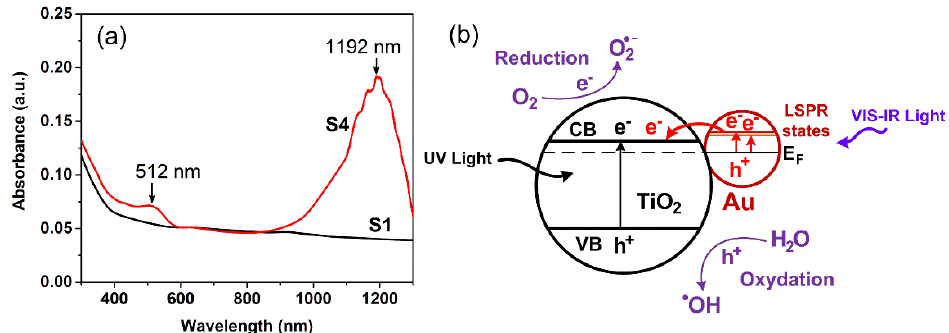
Figure 9. ( a ) Absorption spectra of the solution of S 1 and S 4 prepared by scratching 1 mg powder of TNWs/TNAs and Au-TNWs/TNAs. ( b ) A proposed mechanism for the photocatalytic activity of Au-TiO 2 upon the excitation of the Au surface plasmon band.